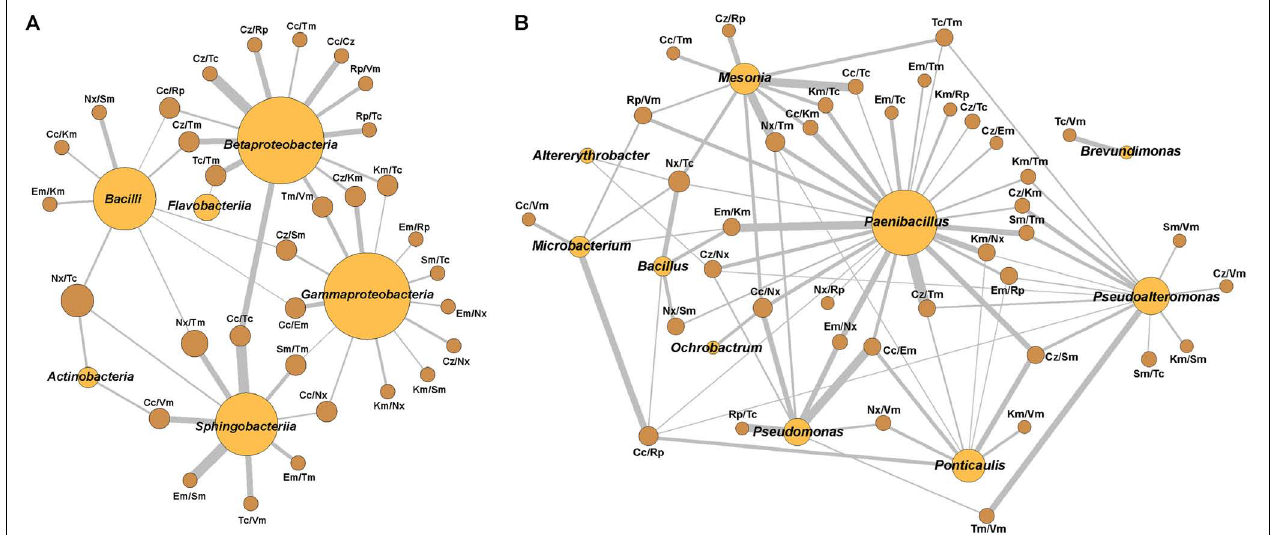
FIGURE 6 | Network relationships of the best-correlated pairs of antibiotic resistances with the class or genus in which they were found. (A) Class, (B) Genus. The wideness of each connecting bar is proportional to the κ index value. Spheres size is proportional to the number of best-correlated ( κ > 0.4) resistances pairs in each class or